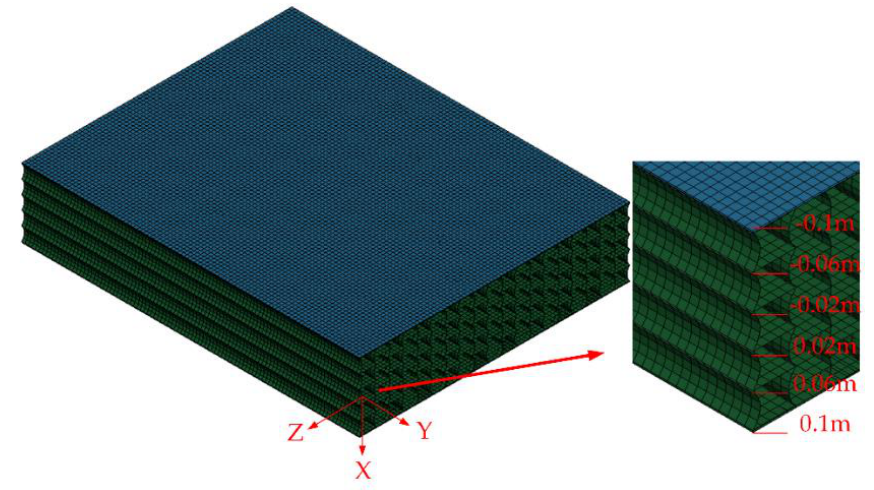
Figure 11. Deflection histories of the concave arc honeycomb. In order to understand the deformation mechanism of the concave arc honeycomb better, displacement distribution along the X direction caused by plastic deformation was studied. For comparison purposes, five points located at each layer were selected as shown in Figure 12, and the displacement along the X direction was plotted in Figure 13. It could be found that uniform deformation appears on most of the points along the X direction except for the only point located on the front face plate. This uniformly distributed deformation of configuration III will provide better protection to the body subjected to blast loads.